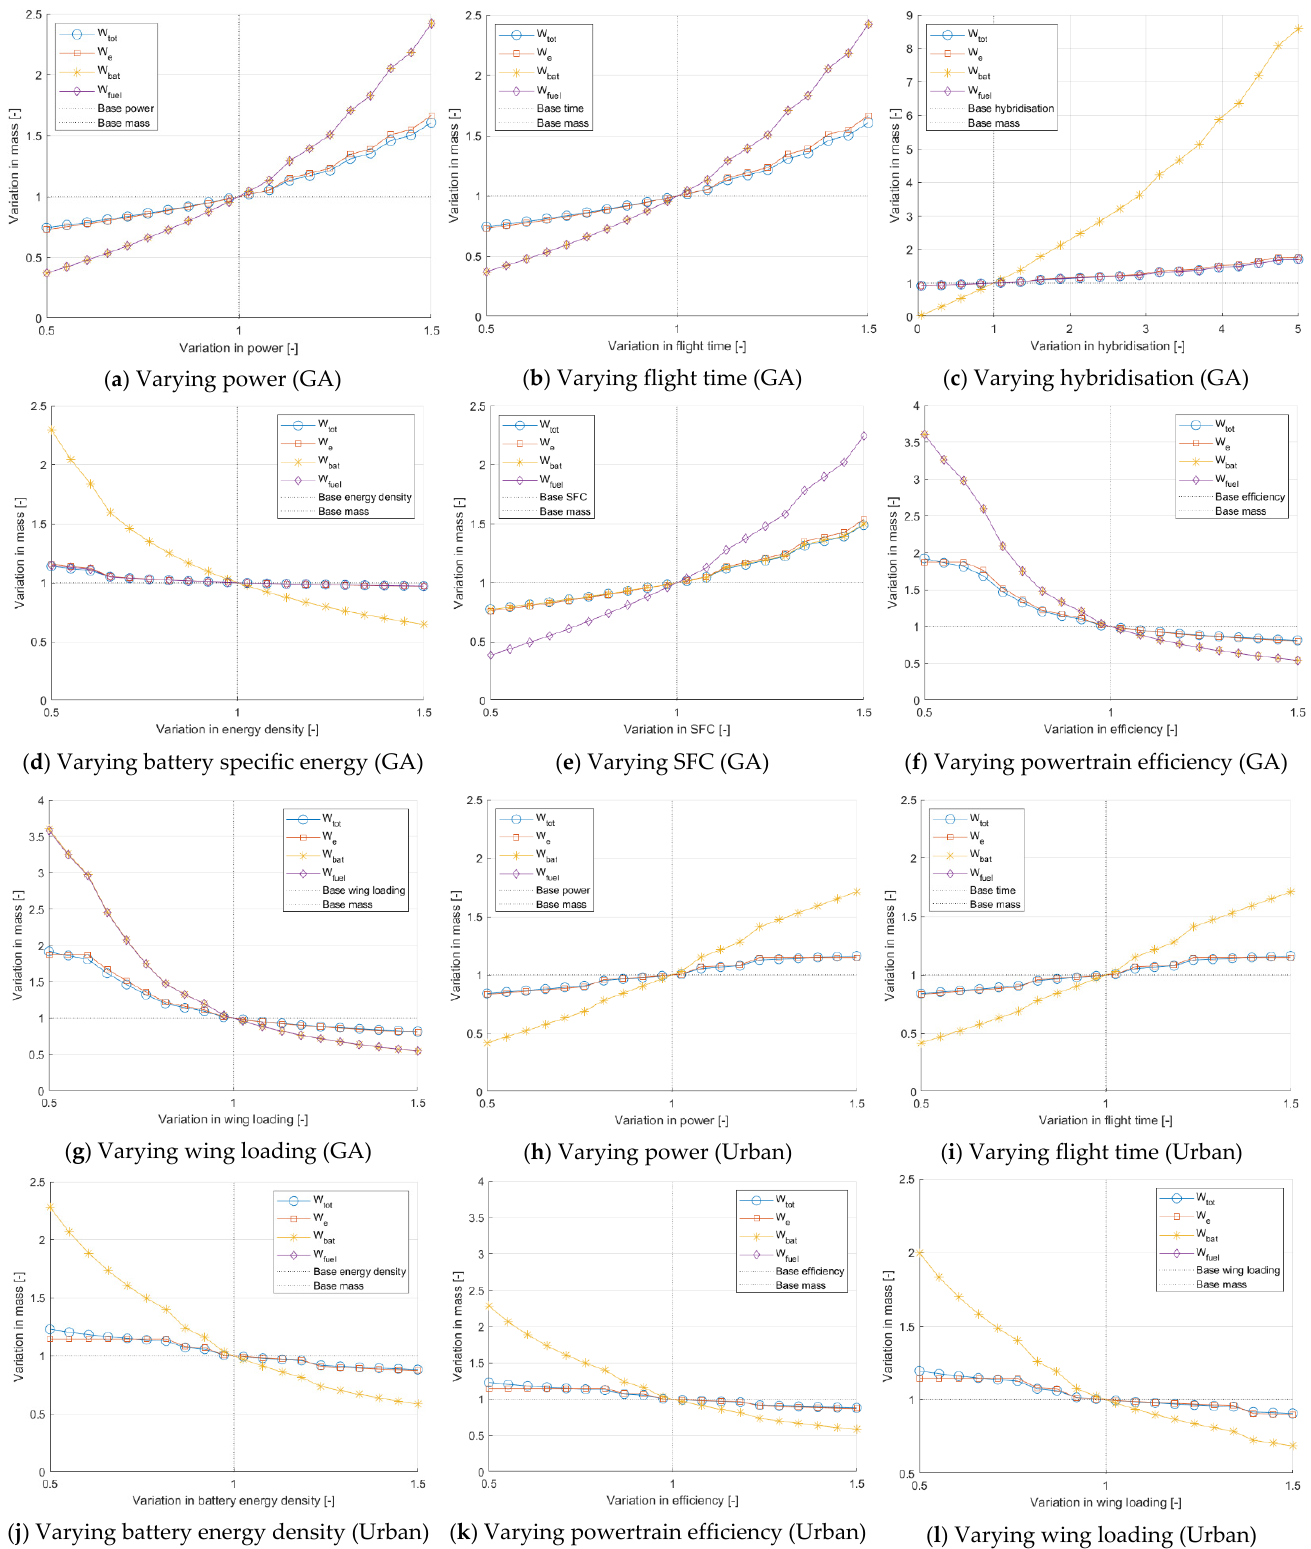
Figure 16. Sensitivity analysis of sizing procedure for General Aviation (GA) and Urban VTOL (5 PAX).